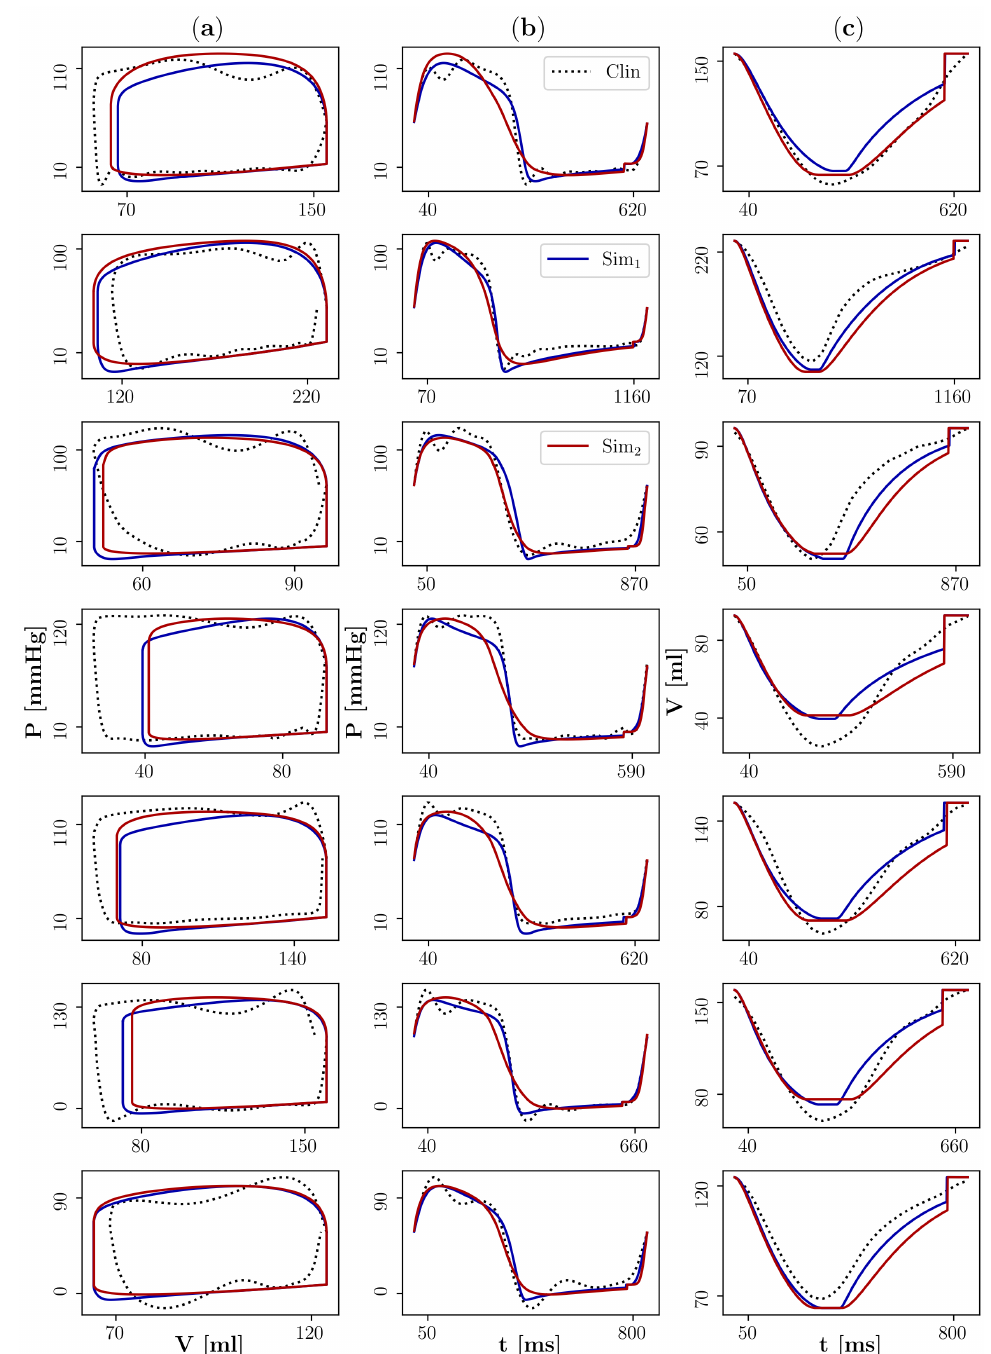
Figure 4. Comparison of simulated and clinical left ventricular pressure and volume after personali- sation. The blue/red lines represent the simulation data Sim 1 /Sim 2 that were produced by the 3D model of human left ventricular EM in the first/second step of the active mechanics personalisation approach. The black dots represent clinical data (Clin). ( a ) Pressure–volume loops, ( b ) pressure traces, and ( c ) volume traces are